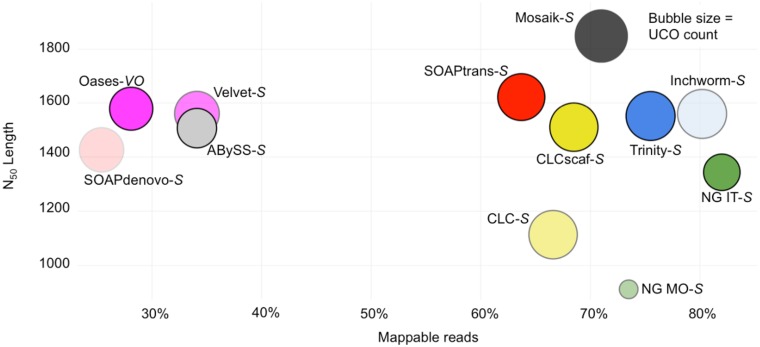
Integration of our reference-independent metrics shows the top 3 are closest to Mosaik-S.Considering the N50 length, proportion of mappable reads, and UCO recovery we recapitulate the reference-dependent ranking of de novo assemblers.